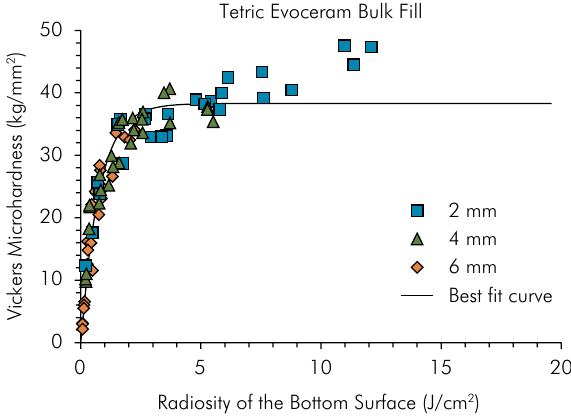
Figure 1. Non-linear regression of Radiosity of the Bottom Surface (J/cm 2 ) and Vickers Microhardness (kg/mm 2 ) for SureFil SDR Flow.